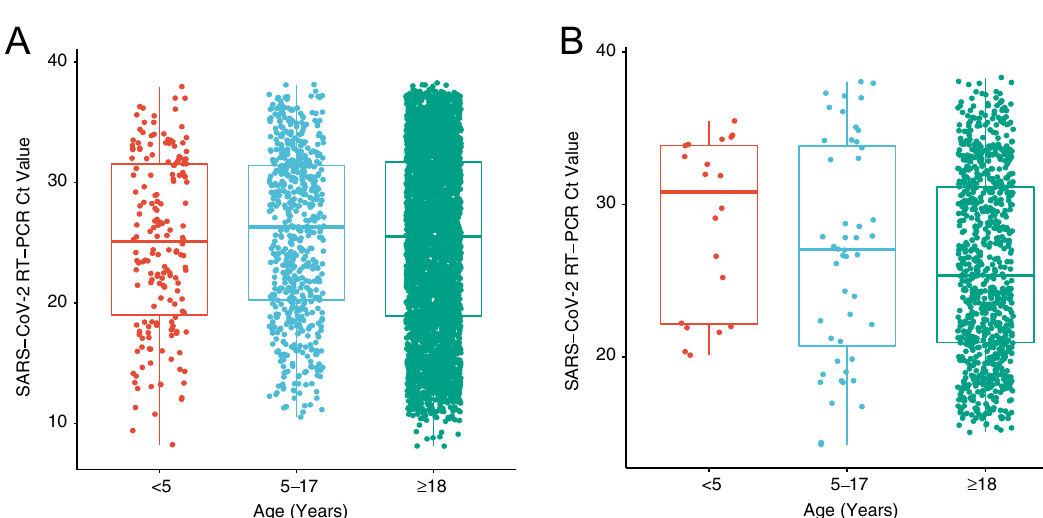
Figure 1. Age distributed nasopharyngeal SARS-CoV-2 viral nucleic acid content. SARS-CoV-2 viral nucleic acid detected by real-time RT-PCR in nasopharyngeal swabs from patients infected with SARS-CoV-2 as detected by ( A ) laboratory A (N = 4619, ANOVA p = 0.18) and ( B ) laboratory B (N = 925, ANOVA p = 0.073). Data are stratified by three age groups, ages < 5; 5–17; 18 and